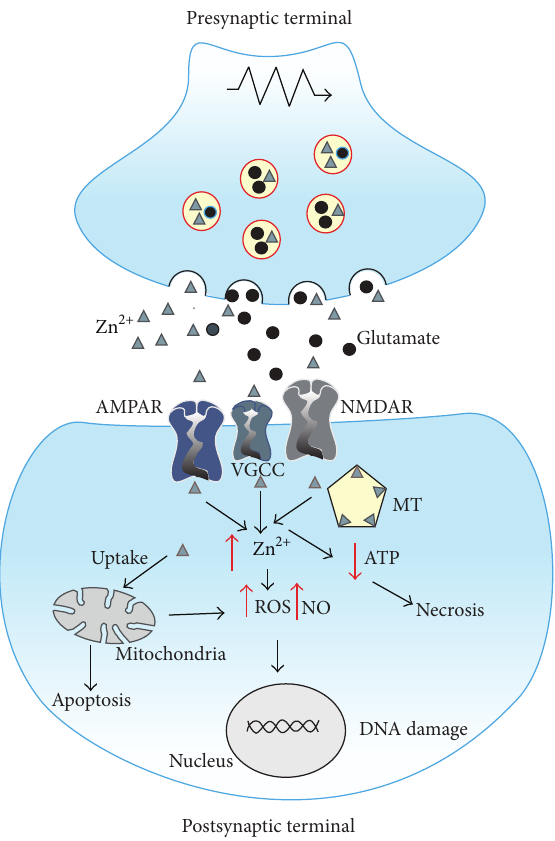
Figure 2: Synaptic interaction between Zn 2+ and glutamate system observed in Alzheimer’s disease (AD); IGlur (ionotropic glutamate receptors); PSD: postsynaptic density; A 𝛽 : Amyloid 𝛽 ; A 𝛽 O: Amy- loid 𝛽